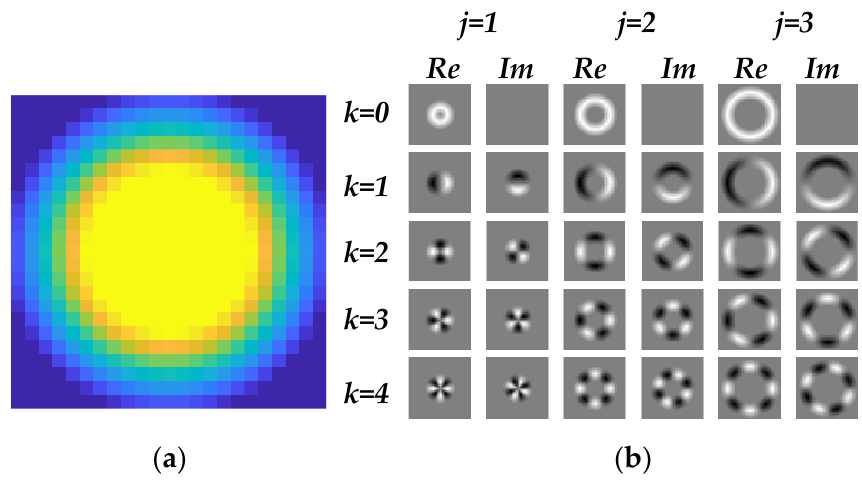
Figure 9. Visualization of trigonometric kernel and cyclic basis functions. ( a ) Self-guided trigonometric kernel (convolution kernel); ( b ) The basis function used for the description of the region. Next, by computing the convolution between the basis function and the Fourier coefficient , we can create the rotation-invariant feature by the following convolu- 𝑉𝑉 𝑗𝑗 , 𝑘𝑘 tion computation: 𝑐𝑐̂ 𝑚𝑚 ( 𝑥𝑥 , 𝑦𝑦 )